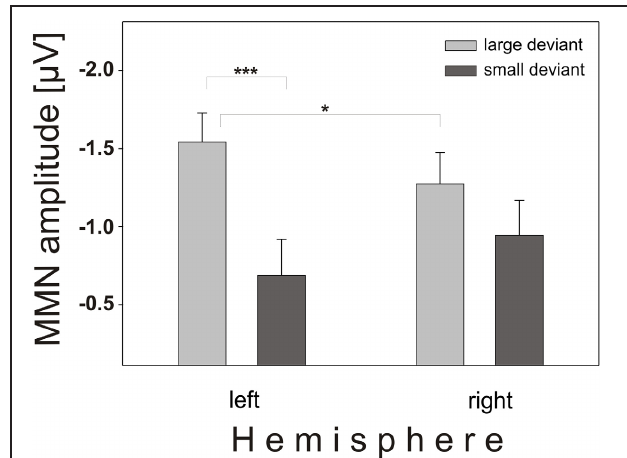
FIGURE 6 | Interaction magnitude × hemisphere. Mean amplitudes and standard error of MMN elicited by large (light gray boxes) and small (dark gray boxes) deviants over left and right scalp positions. While the large deviant caused larger amplitudes over the left hemisphere, the small deviant elicited larger amplitudes over the right